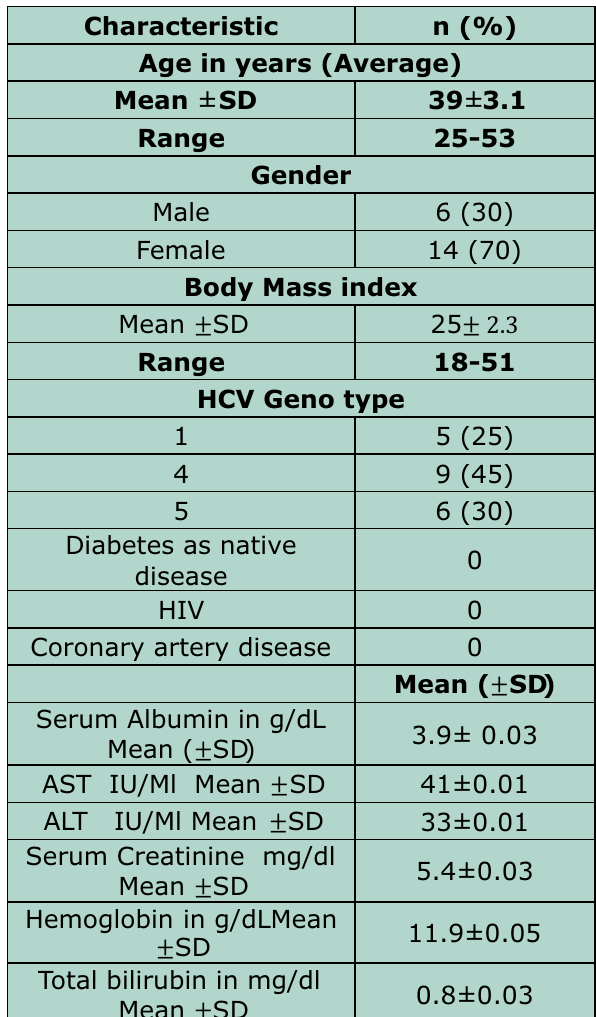
Table-I: Patient profile and baseline